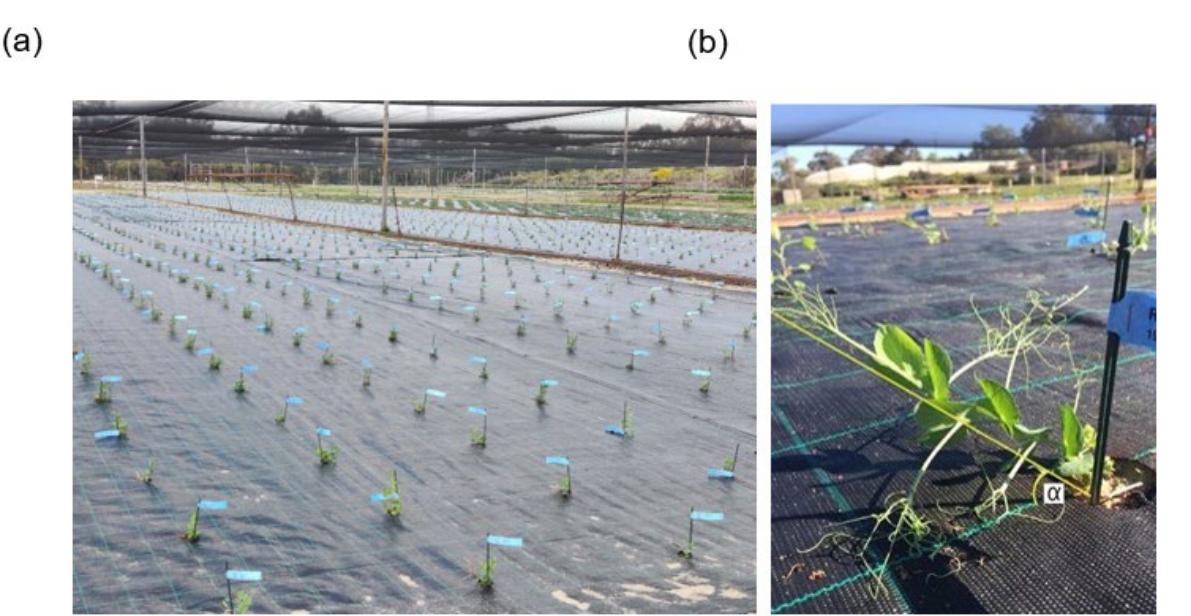
Figure 1. Field trial of Cycle 3 experimental field pea population in UWA field station, Shenton Park 6008, Western Australia in June 2019. ( a ) 1600 single plant plots sown in a square grid design partially replicated trial, comprising 668 S 0 genotypes, 612 S 2+ genotypes and 320 control plants (replicates of 15 control varieties); ( b ) close-up of a single plant immediately before first flower showing the stem angle above horizontal (EAngle) measured in degrees above horizontal (α).